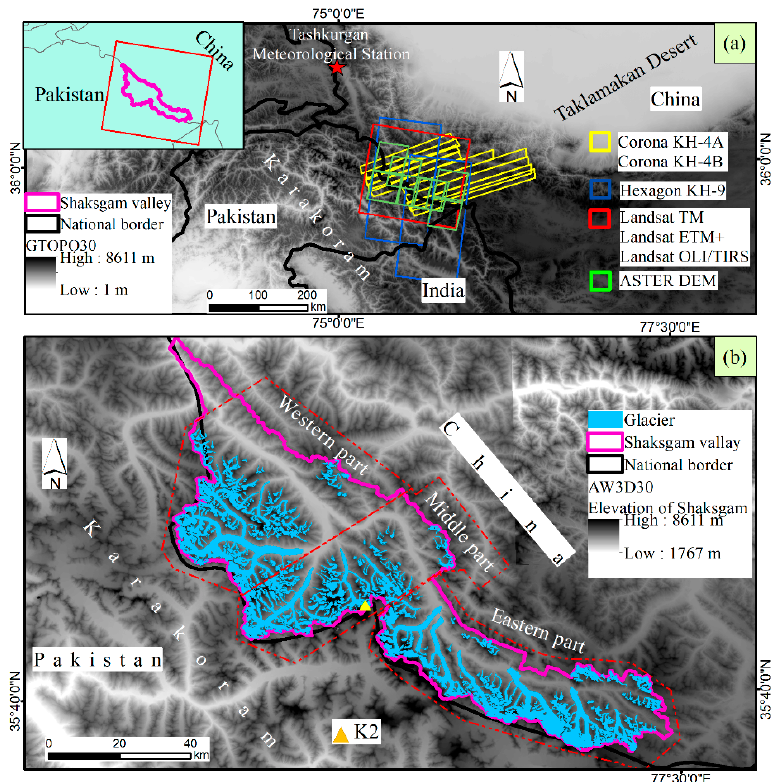
Figure 3. Utilized data coverage in this study ( a ) and the overall location of Shaksgam Valley ( b ).